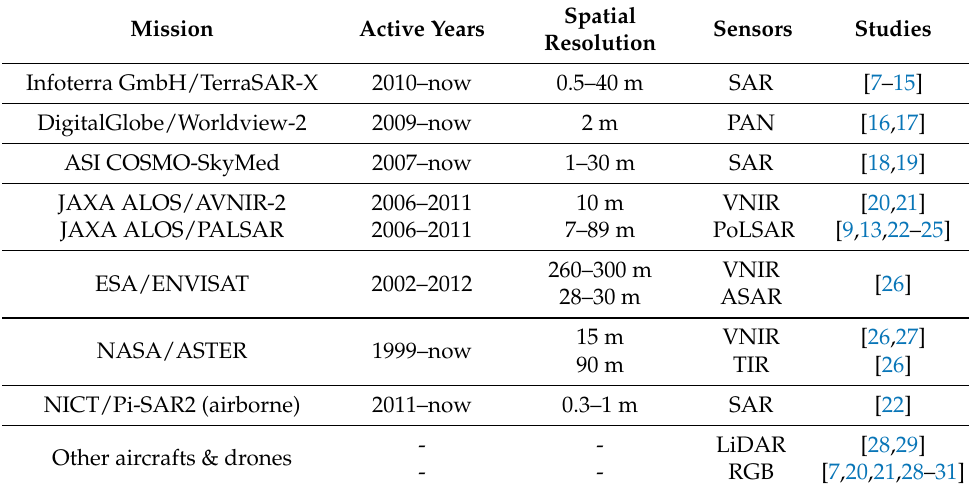
Table 1. List of missions whose data were used for case studies on the 2011 great tsunami. The first part of the table shows satellite missions, and the second part shows other airborne options. Mission Active Years